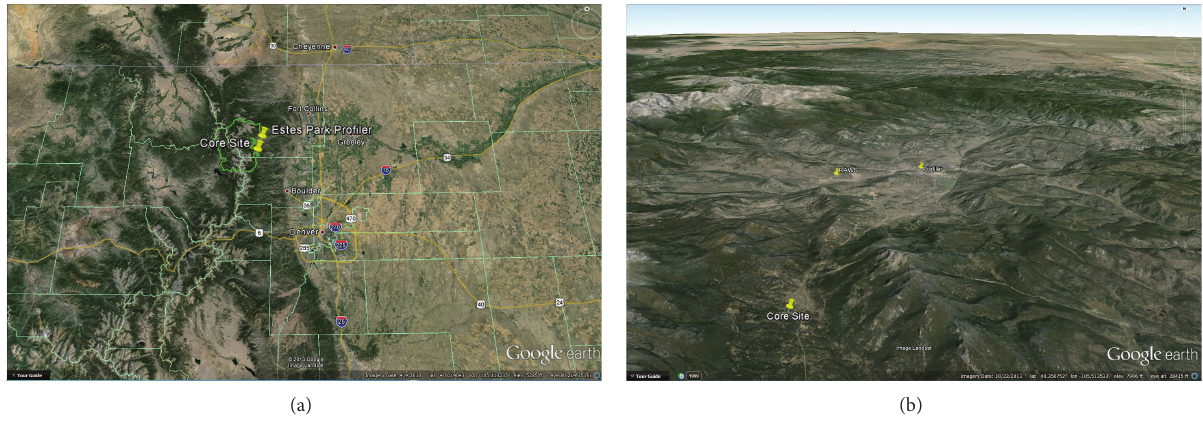
Figure 1: Views of the RoMANS core site and meteorological measurement sites in Estes Park, CO (yellow pins), generated with Google Earth. Both views are looking north. Panel (a) shows RMNP boundaries in heavy green, Colorado county boundaries in pale green, and major highways in yellow. The North Platte River valley is the dark green area mostly along Highway 34. Panel (b) shows the orientation of the local valleys and surrounding terrain. The core site and the profiler are approximately 12km apart. The profiler and the RAWS sites are about 3.4 km apart. On the larger map, Cheyenne, WY, and Denver, CO, are approximately 162 km